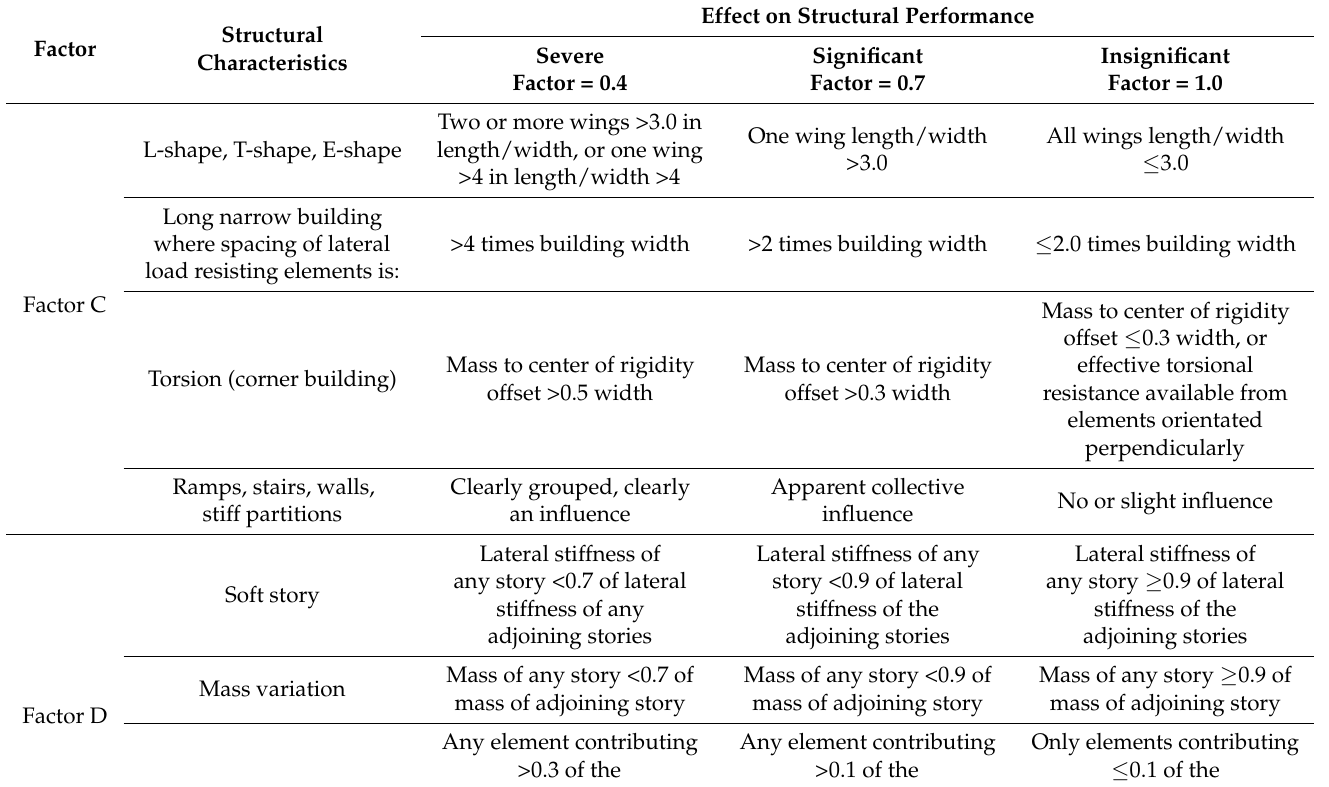
Table 7. Guide to the severity of critical structural weaknesses. (Adapted from